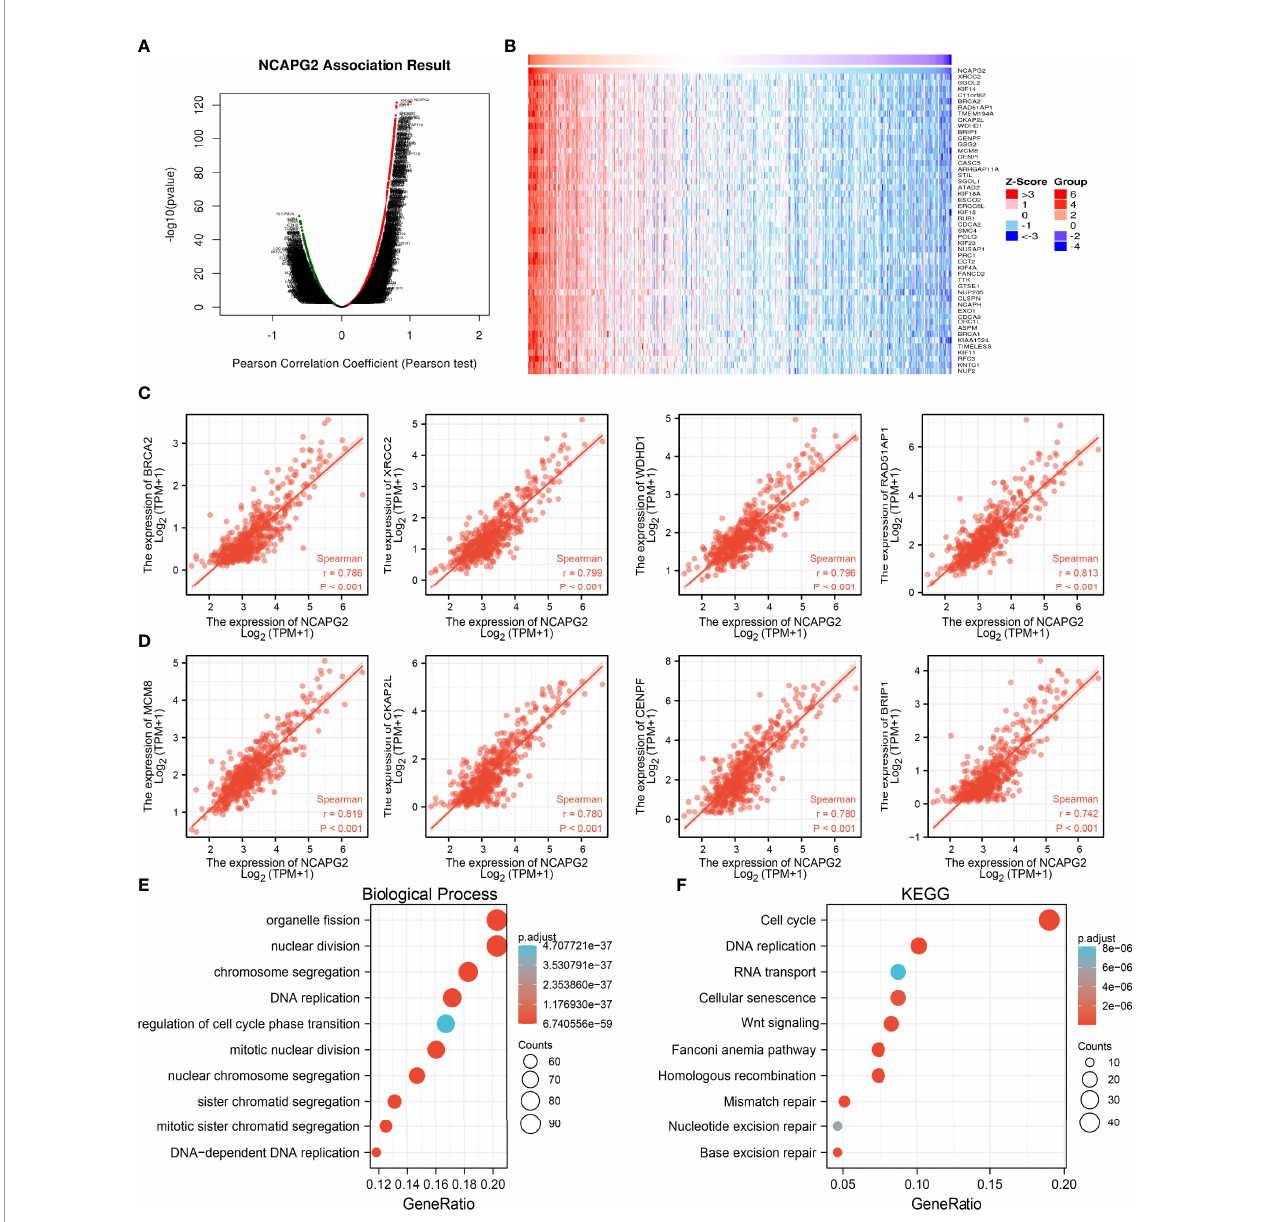
FIGURE 8 | Analysis the function of NCAPG2 expression in LGG. (A – D) Analysis the co-expression genes of NCAPG2 in LGG examined by linkomics databases. (E) Analysis the biology process involved by NCAPG2 in LGG. (F) Analysis the KEGG signaling pathway of NCAPG2 in